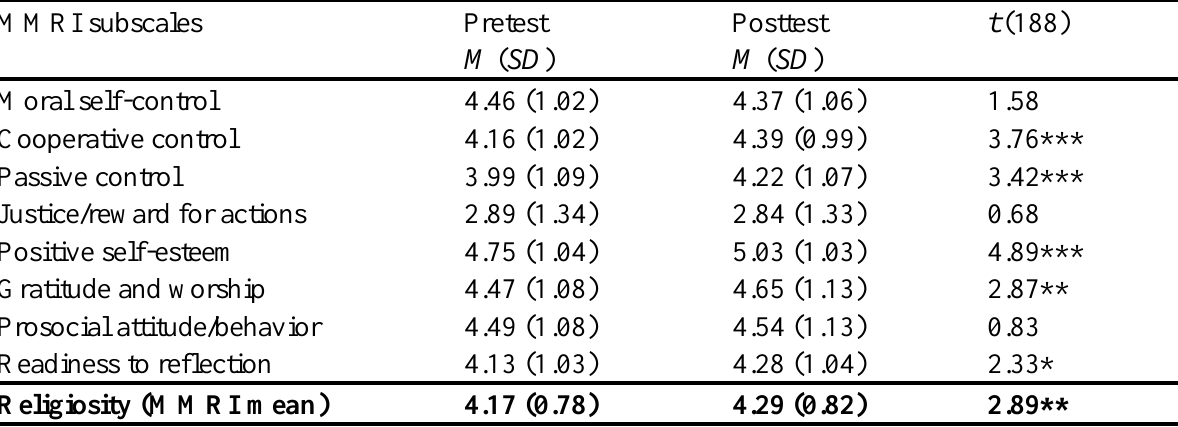
Table 2. Changes of religiositiy (Munich Motives for Religiosity Inventory (MMRI) subscales) during treatment.